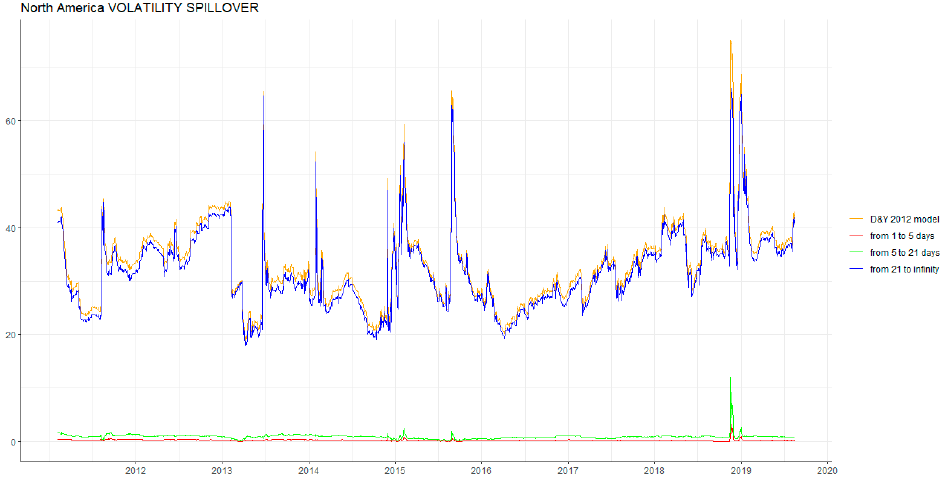
Figure A10. Total volatility spillover of DY12 and BK18 in North America (Windows 370).